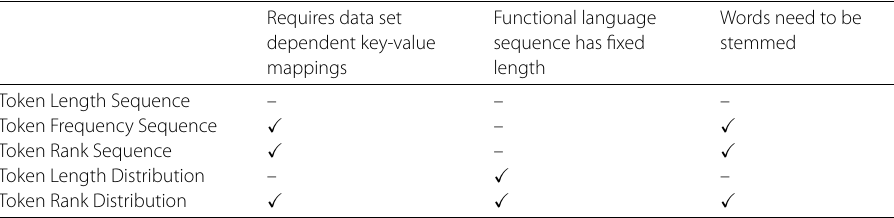
overview of the implementation details of the five mapping methods